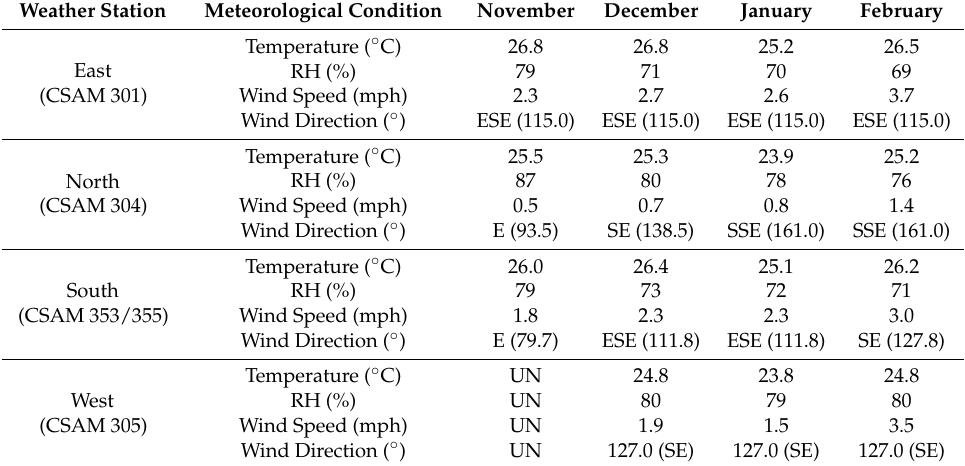
Table 1. The monthly average temperature ( ◦ C), relative humidity (%), wind speed (mph) and 1 h median wind direction ( ◦ ) for the East, North, South, and West weather stations. “UN” indicates measurements for the period were